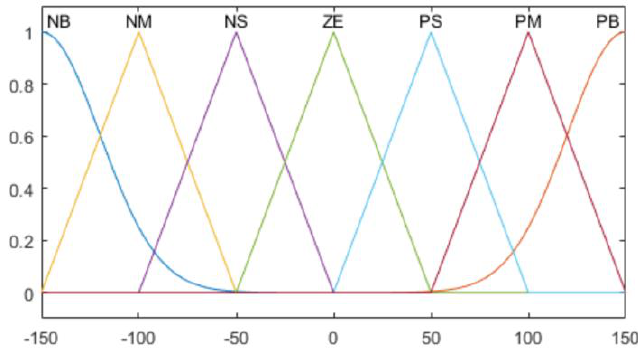
Figure 16. Contact pressure derivative MFs.